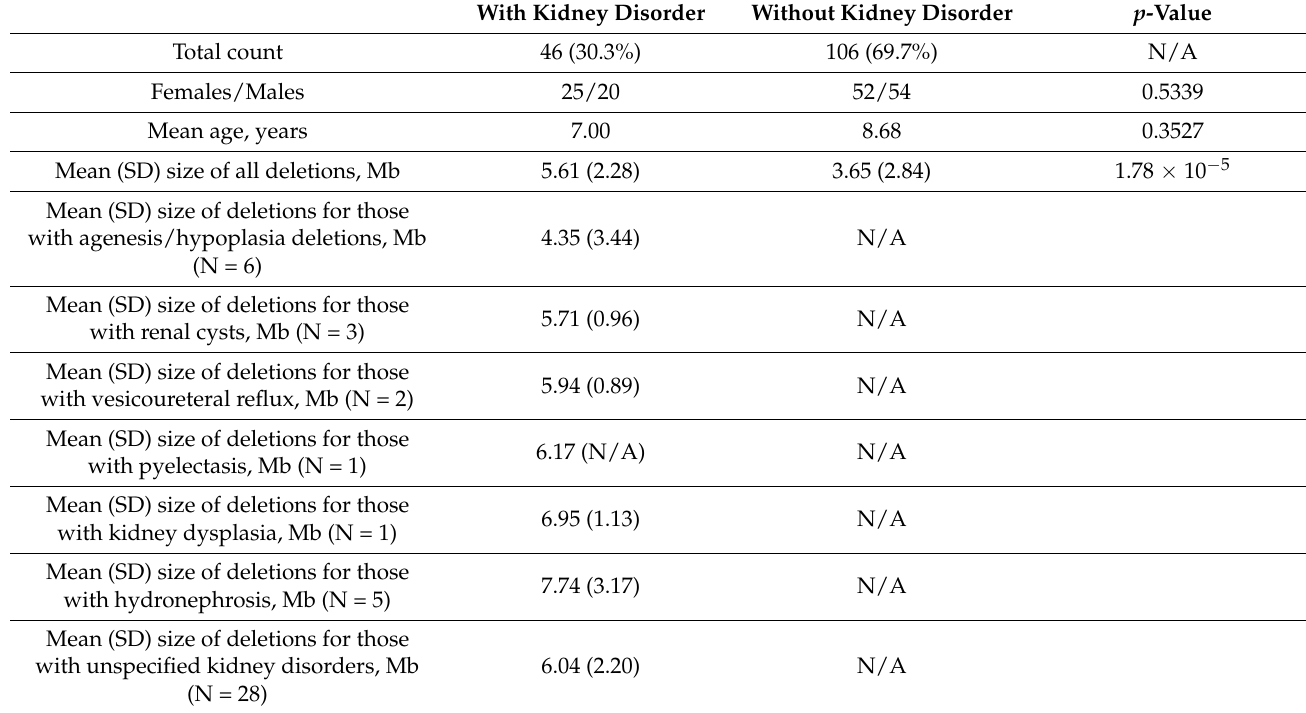
Table 4. Characteristics of the study population (n = 152) and association with deletion size means. With Kidney Disorder Without Kidney